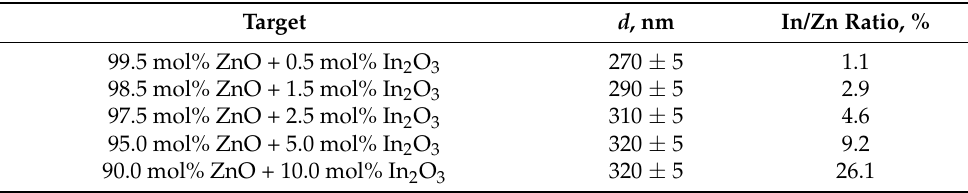
Table 1. SEM and EDX data on film thickness d and in content for the deposited ZIO thin films.